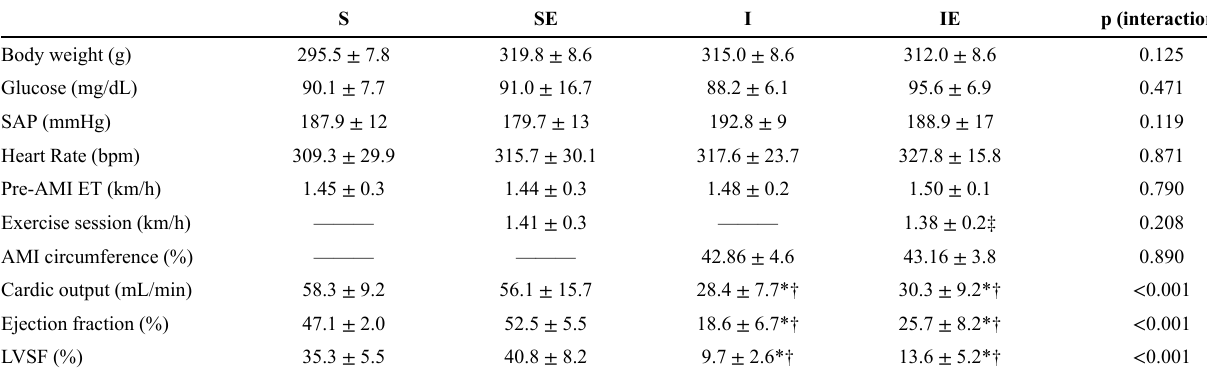
Table 1 - Baseline characteristics of the study groups.